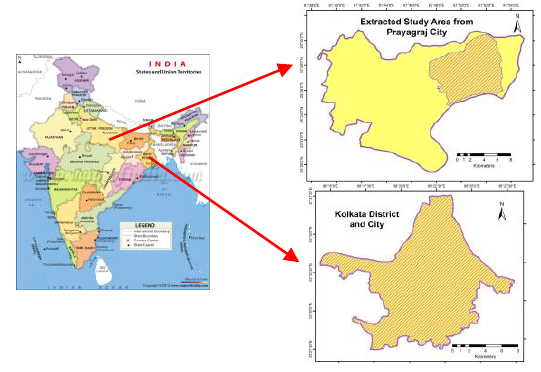
Figure 1. Location and extent of study areas